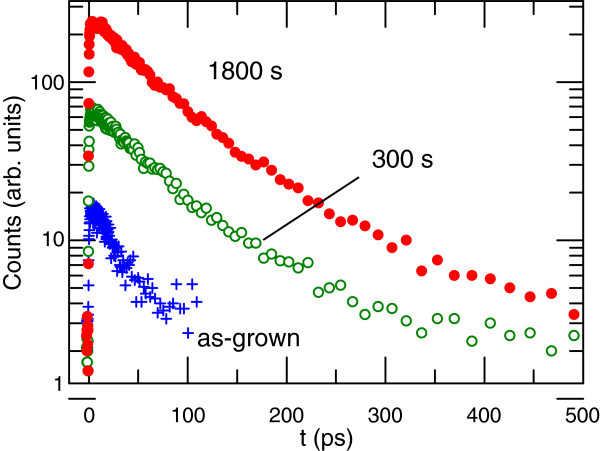
Decay profiles for sample 4 comprising GaNAsSb measured at λ = 1,250 nm. Annealing time at Tann = 750°C was 0, 300, and 1,800 s.